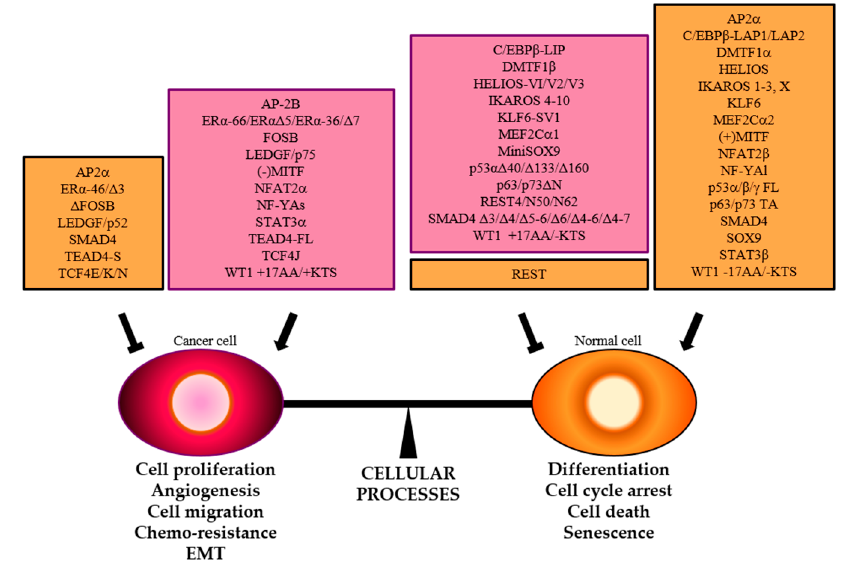
Figure 6. The balance between cellular processes that enhance or inhibit cancer hallmarks is controlled by TFs. Specific splice variants that promote (purple boxes) or hamper (orange boxes) neoplastic transformation are reported.